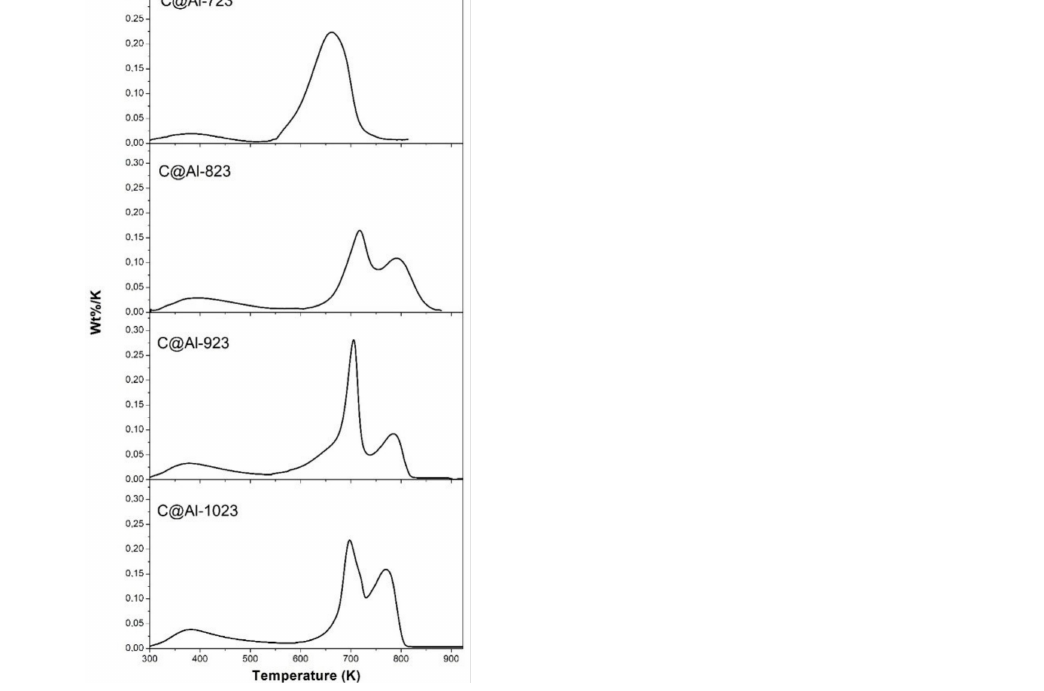
Figure 3. Profiles of the differential TGA (DTGA) for the thermal stability of the C@Fe–Al 2 O 3 hybrids in